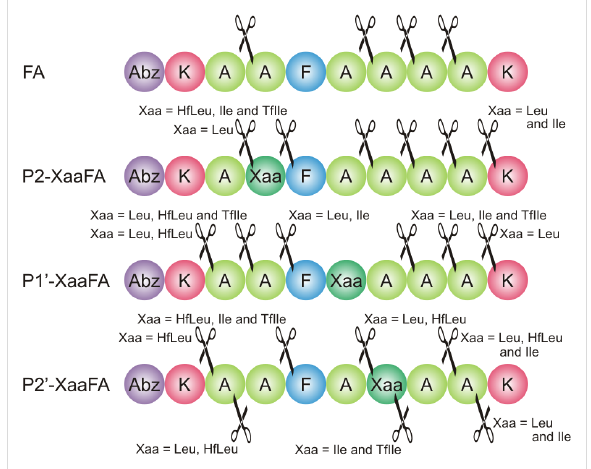
Figure 7: Cleavage positions for digestion of the different peptides with